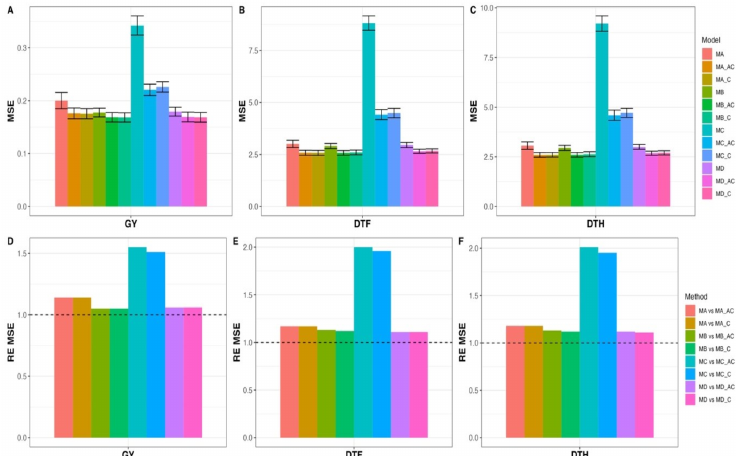
Figure 3. Prediction performance across environments (years) for each trait for all models—MA, MA_C, MA_AC, MB, MB_C, MB_AC, MC, MC_C, MC_AC, MD, MD_C, and MD_AC—in terms of mean squared error (MSE) under untested lines in a tested environment cross validation strategy. The relative efficiencies (RE_MSE) were computed by dividing the MSE of model MX by the MSE of model MX_C or MX_AC model, with X taking the values of ( A – D ). ( A – C ) correspond to traits GY, DTF, and DTH fitted to the 12 models shown on the right-hand side. ( D – F ) correspond to traits GY, DTF, and DTH comparing fitted to models shown on the right hand